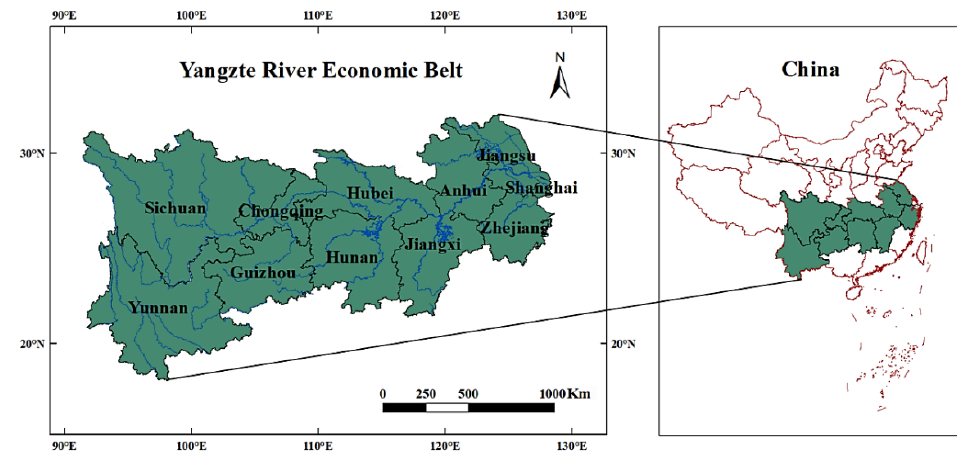
Figure 1. Location of the Yangtze River Economic Belt .